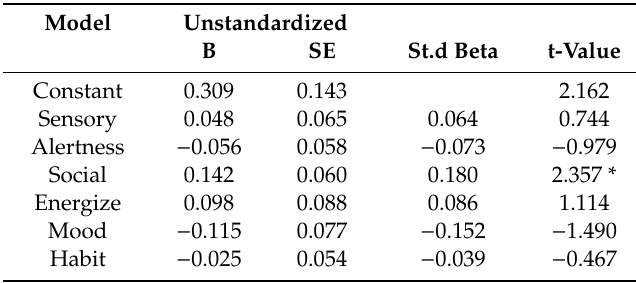
Table 7. Results of regression analysis of motivations influencing tea consumption.